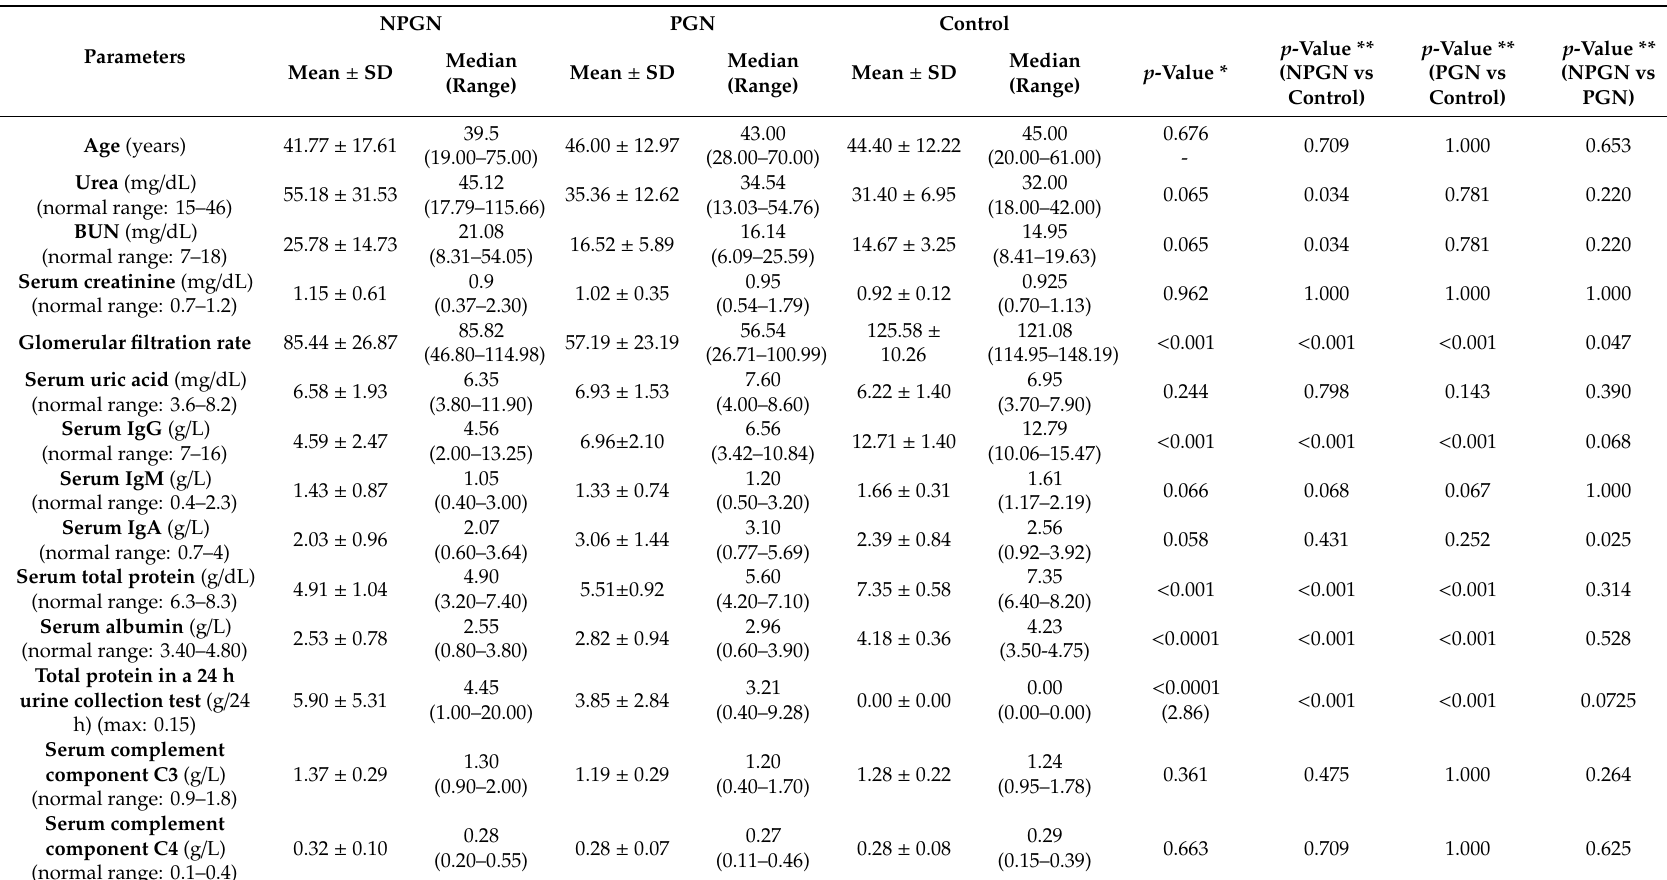
Table 1. Levels of selected proteins, complement components, and renal function parameters in patients with proliferative (PGN) and non-proliferative (NPGN) glomerulonephritis and